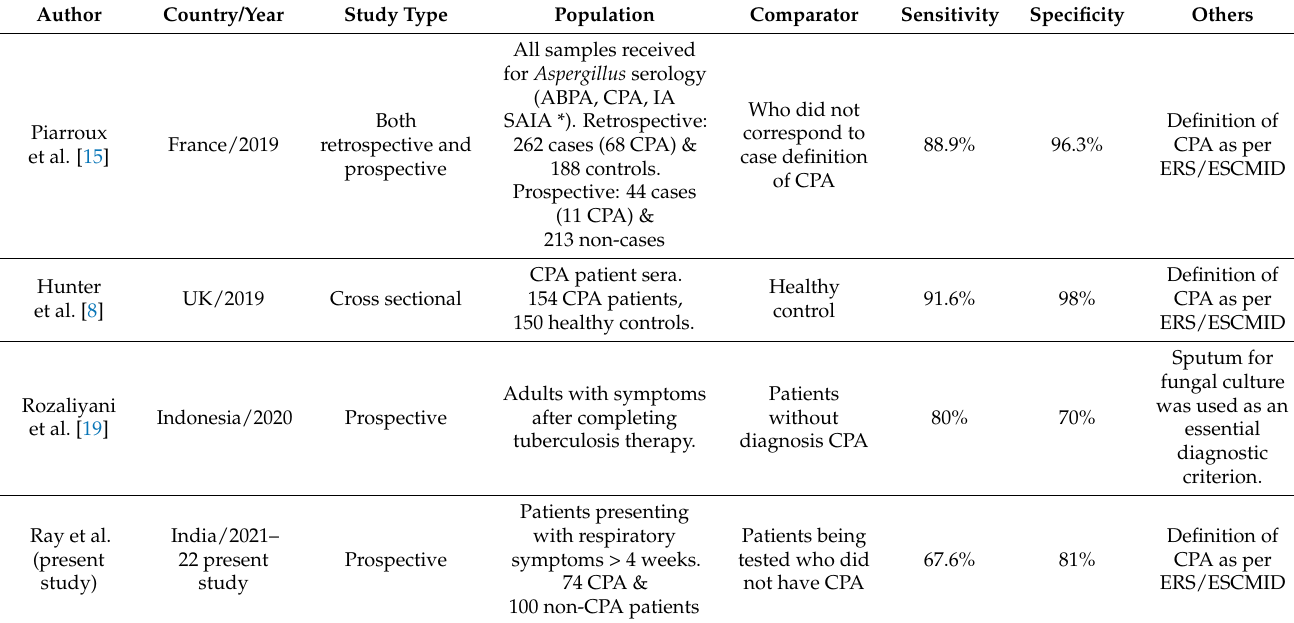
Table 6. Characteristics of different studies reporting diagnostic performances of LDBio LFA.